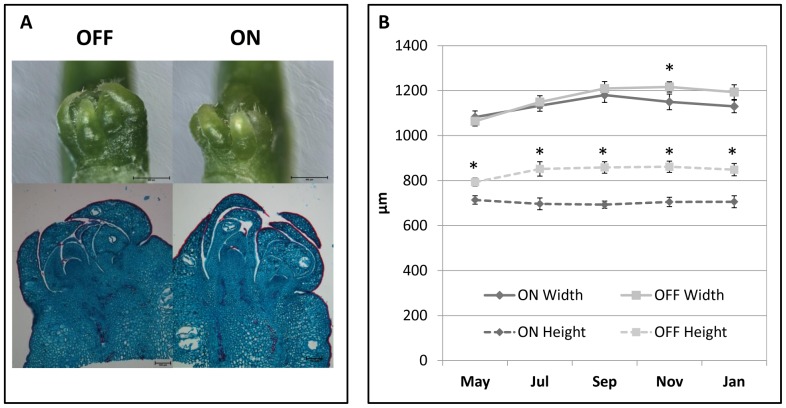
Bud morphology in ON- and OFF-crop trees.Buds were collected from ON- and OFF-crop trees in mid-July (A) and during the indicated months (B), fixed, dissected, dyed and photographed. Bud width and length were measured following photography (B). Mean values of 50 buds ± SE. Stars denote a significant difference between ON and OFF buds during the same time point (P<0.02).